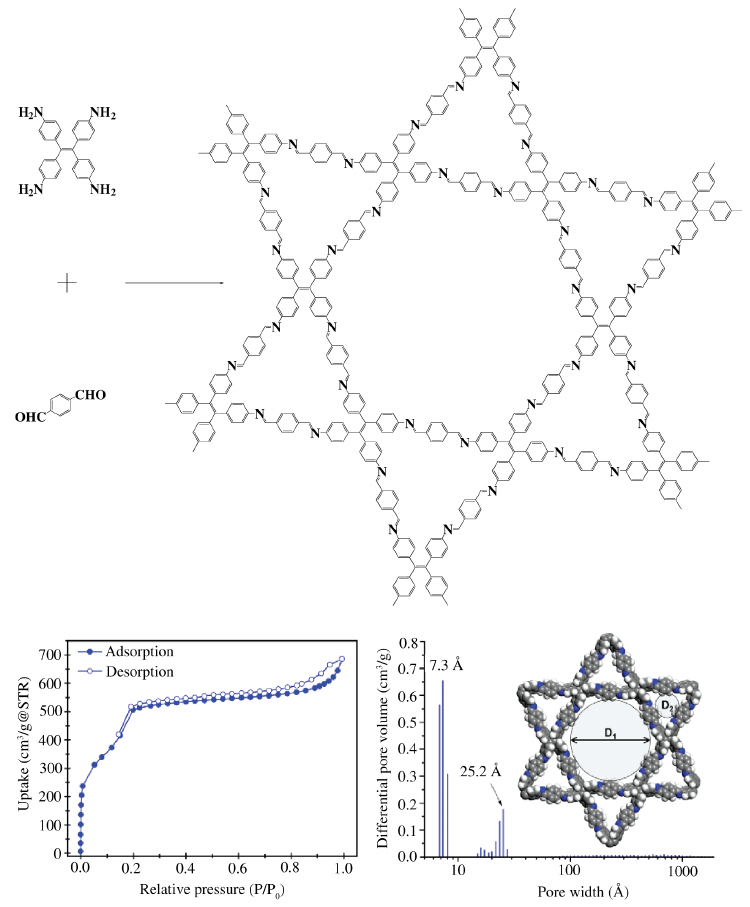
Figure 11: Synthesis and structure, N the dual-pore